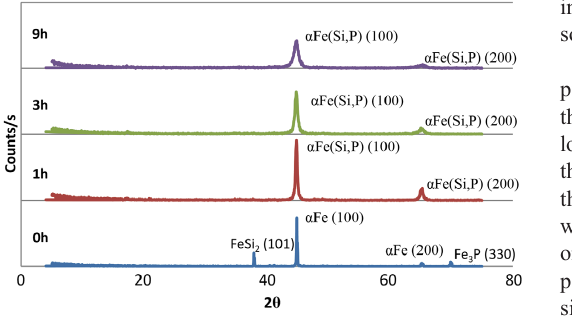
Figure 6. XRD with 0h, 1h, 3h and 9h of milling 12